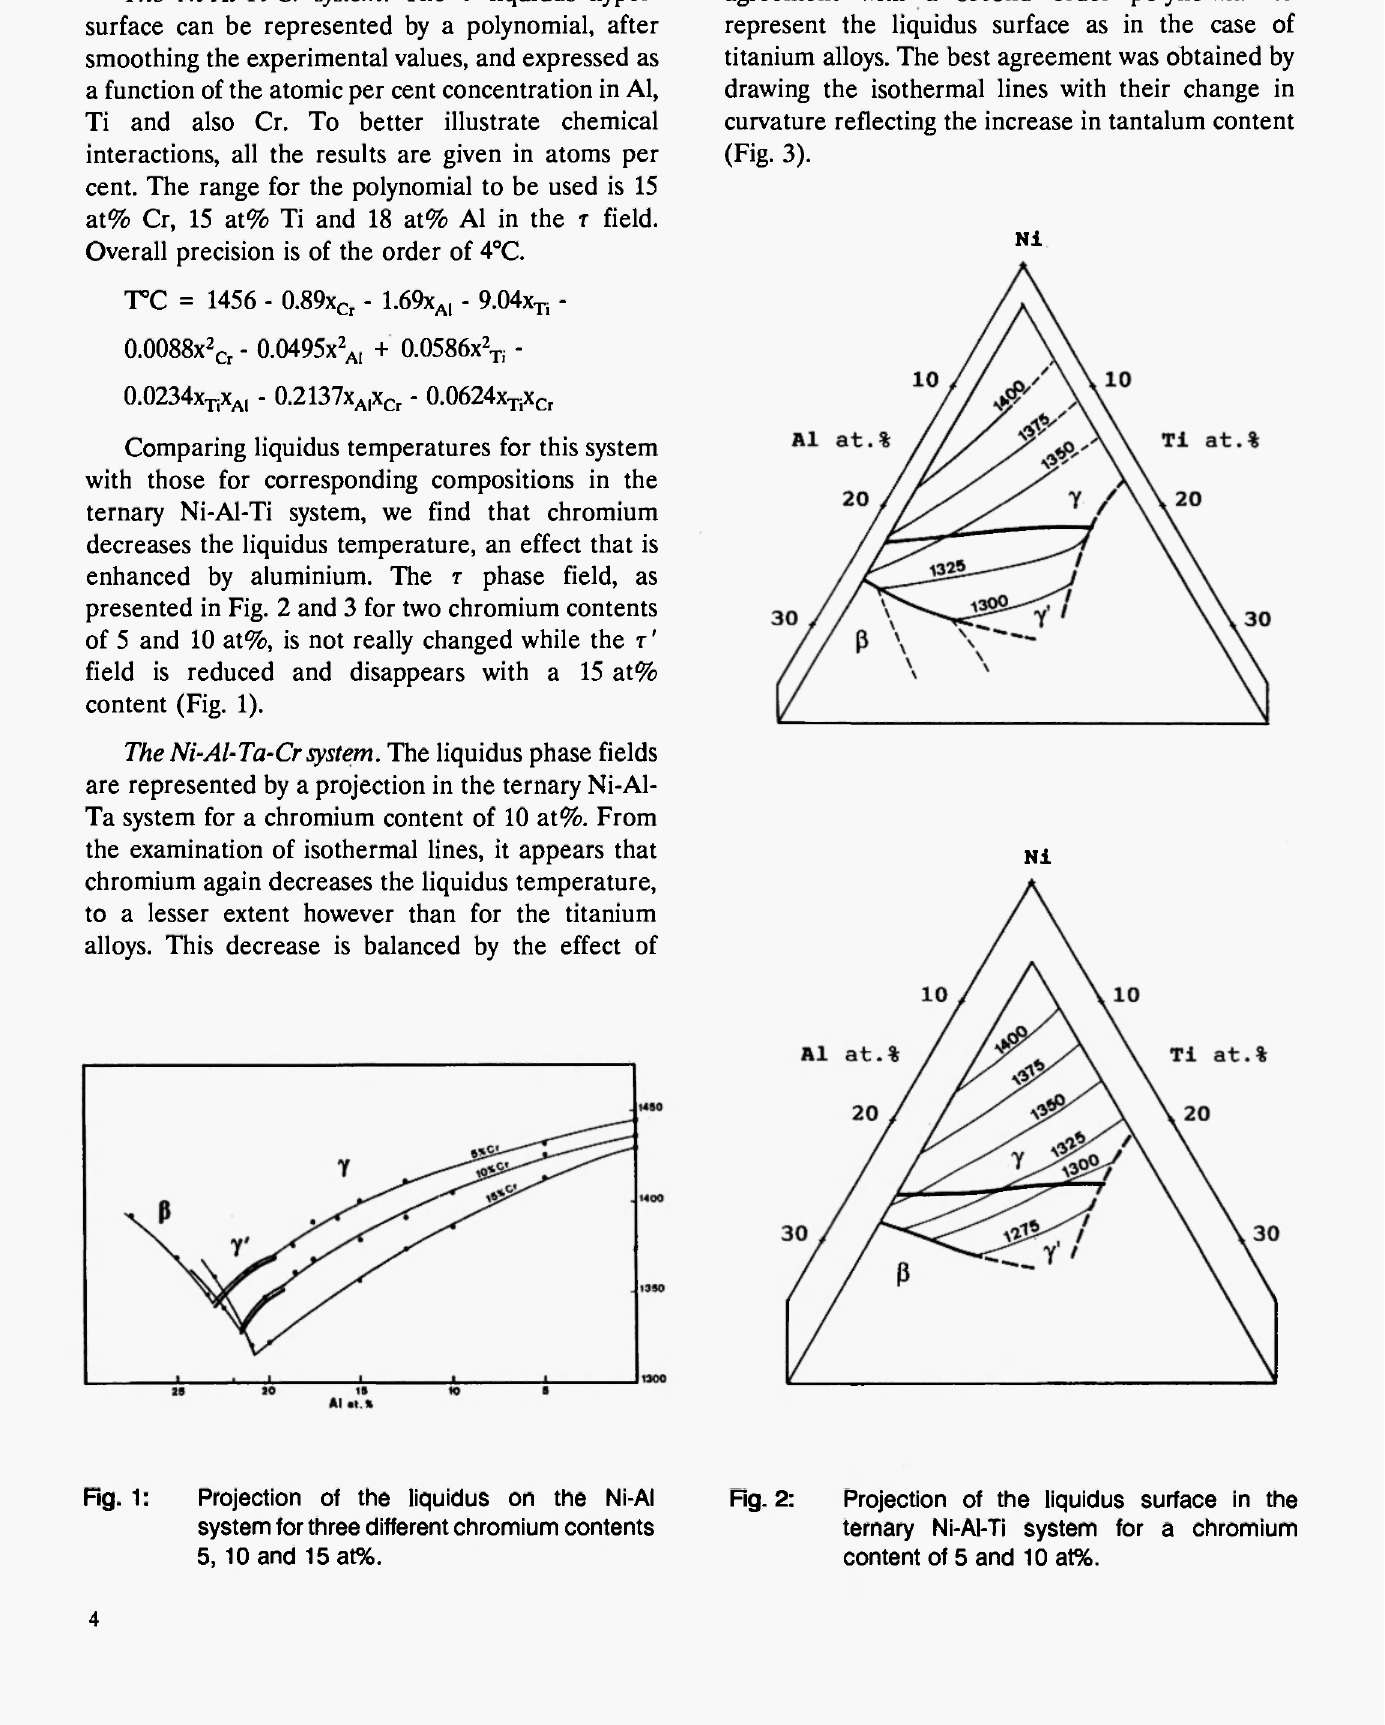
Fig. 1: Projection of the liquidus on the Ni-AI system for three different chromium contents 5, 10 and 15 at%.